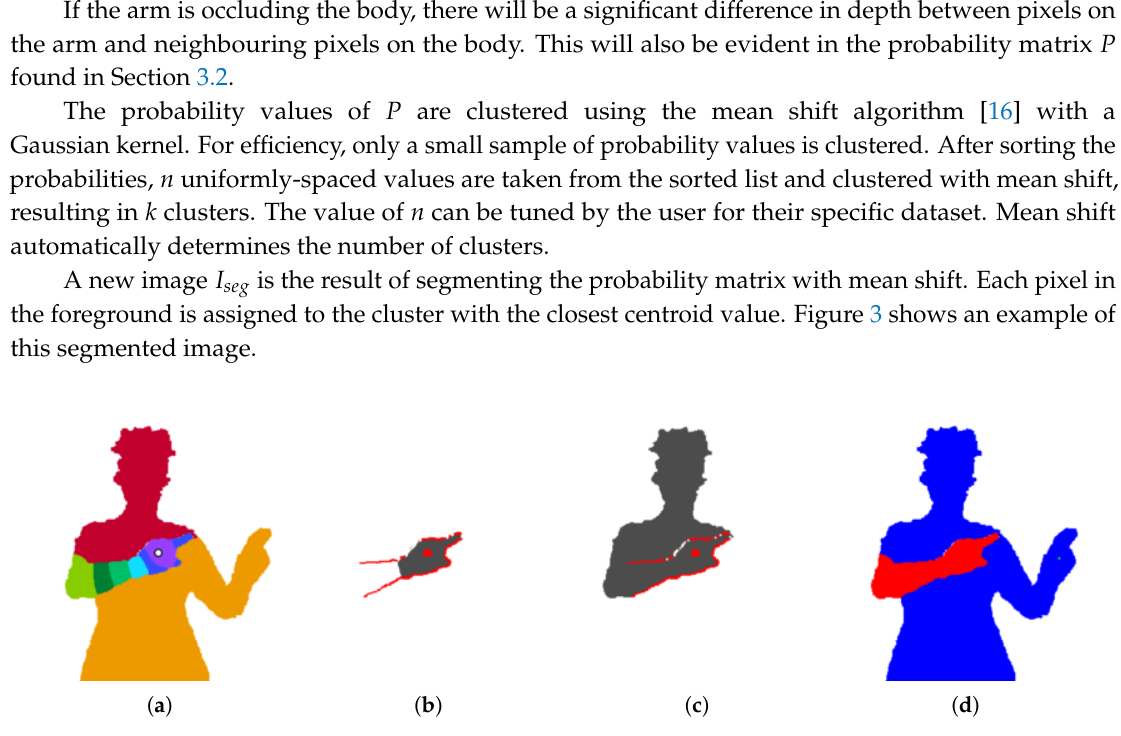
Figure 3. Segmenting the arms. ( a ) Segmented image resulting from clustering probability values of the right arm with mean shift. ( b ) Potential arm segment (grey) and strong gradient pixels (red). While this binary arm segment B i does not cut across the gradient, its complement ∼ B i does. This invokes a high cost. ( c ) Another potential arm segment. The segment B i cuts across the gradient, also invoking a high cost. ( d ) Final arm segments (the left segment is minuscule). Only the right arm is